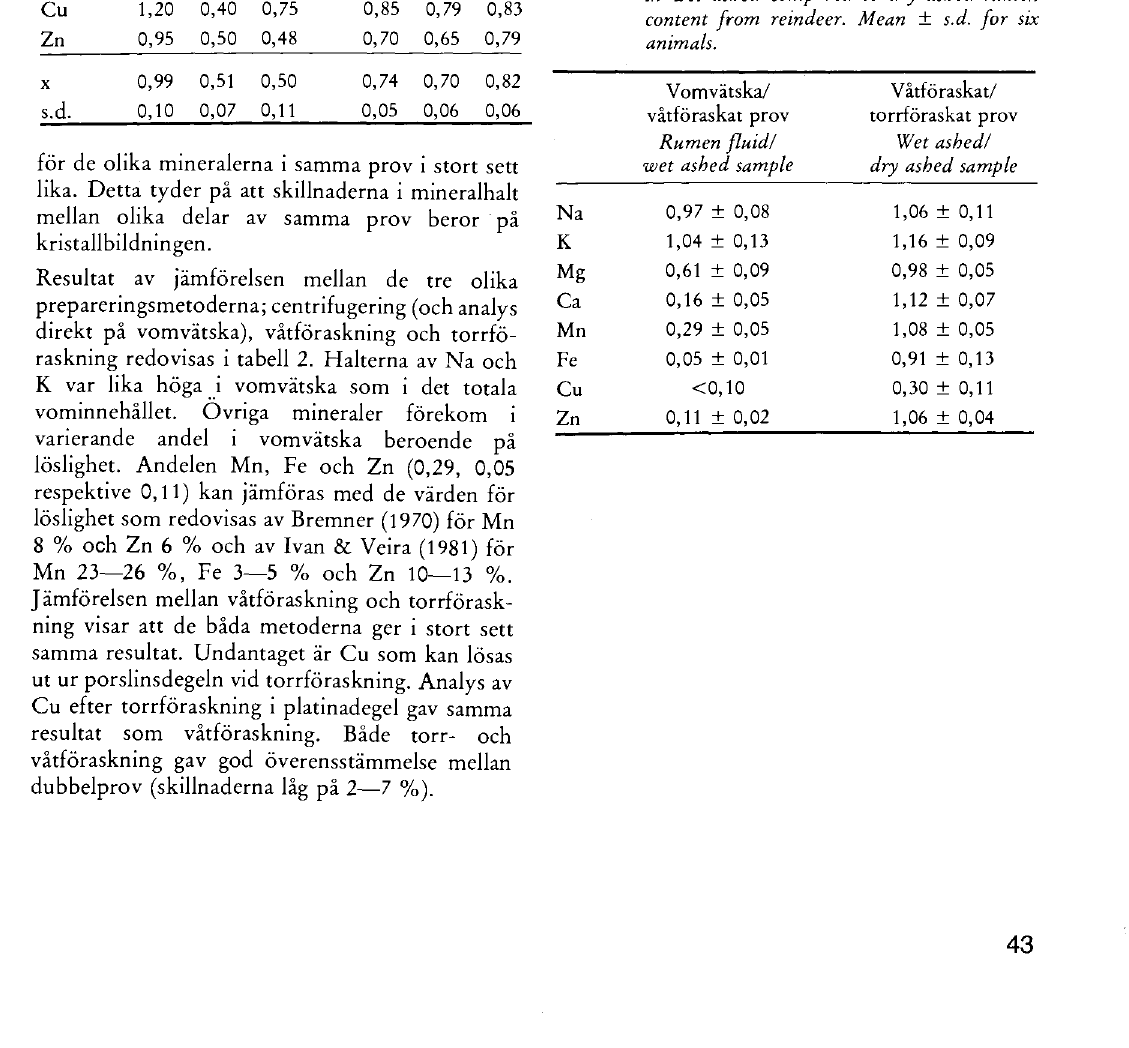
Table 2. Relative concentration of minerals in rumen fluid compared to wet ashed rumen content and in wet ashed compared to dry ashed rumen content from reindeer. Mean ± s.d. for six